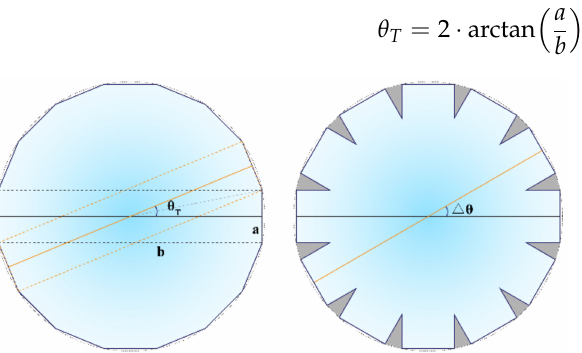
Figure 5. The RRA system’s equivalent synthetic aperture at different angular intervals. ( a ) The synthetic aperture when ∆ θ = θ T . The rectangular apertures form a complete regular hexadecimal. ( b ) The synthetic aperture when ∆ θ > θ T . The synthetic aperture cannot cover the gray triangular areas, and the spatial frequency information in these directions is